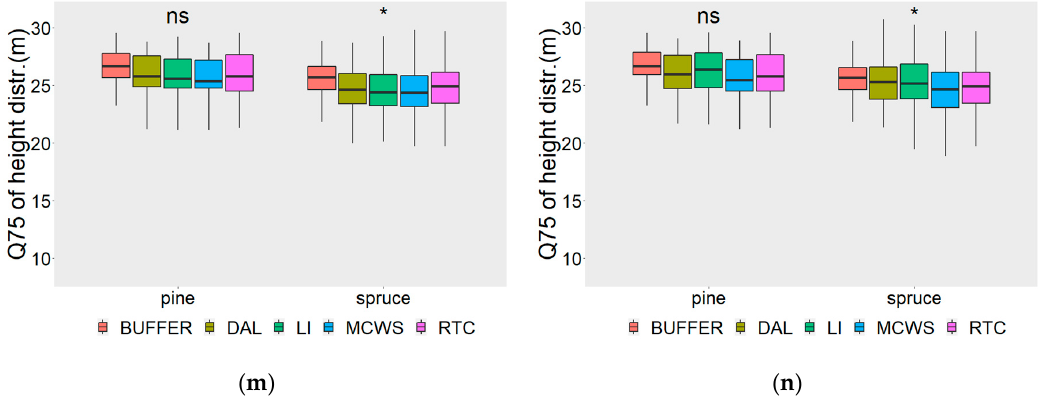
Figure 4. The distribution of extracted individual tree crown features and significant di ff erences among RTC and automatically delineated crowns within disturbance classes of the las02 dataset (left column) and las1 dataset (right column): ( a ) NDRE boxplots of las02; ( b ) NDRE boxplots of las1; ( c ) NDVI boxplots of las02; ( d ) NDVI boxplots of las1; ( e ) ENDVI boxplots of las02; ( f ) ENDVI boxplots of las1; ( g ) Crown area boxplots of las02; ( h ) Crown area boxplots of las1; ( i ) Q25 of height distribution boxplots of las02; ( j ) Q25 of height distribution boxplots of las1; ( k ) median of height distribution boxplots of las02; ( l ) median of height distribution boxplots of las1; ( m ) Q75 of height distribution boxplots of las02; ( n ) Q75 of height distribution boxplots of las1. * marks the significant differences (the significance level α = 0.05) among applied delineation methods within each feature’s class. The significant differences among delineation methods were revealed only within sbbd and sbbg class of spectral features. The significant variances among delineation methods were obtained within each tree species class of all elevation features. These significant differences were further investigated using post-hoc treatment (BUFFER, DAL, LI, MCWS) versus control (RTC) multiple comparisons tests of each dataset for spectral (Table 11) and elevation (Table 12) features. Class Multiple Comparisons Table 11. The treatment versus control multiple comparison test after the Kruskal–Wallis test of spectral features. True (T) or False (F) marks statistically significant/insignificant differences between pairs. Significant differences among las02 and las1 within treatment versus control tests caused by significantly lower segmentation accuracy of las1 are highlighted in yellow.